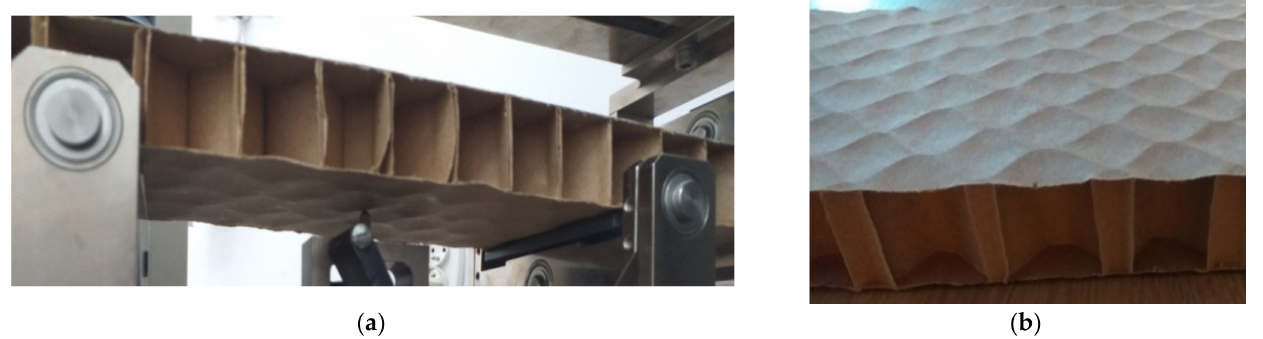
Figure 7. Buckling of compressed flat surface of cellular paperboard ( a ), defects in the shape of the flat layer of honeycomb paperboard ( b